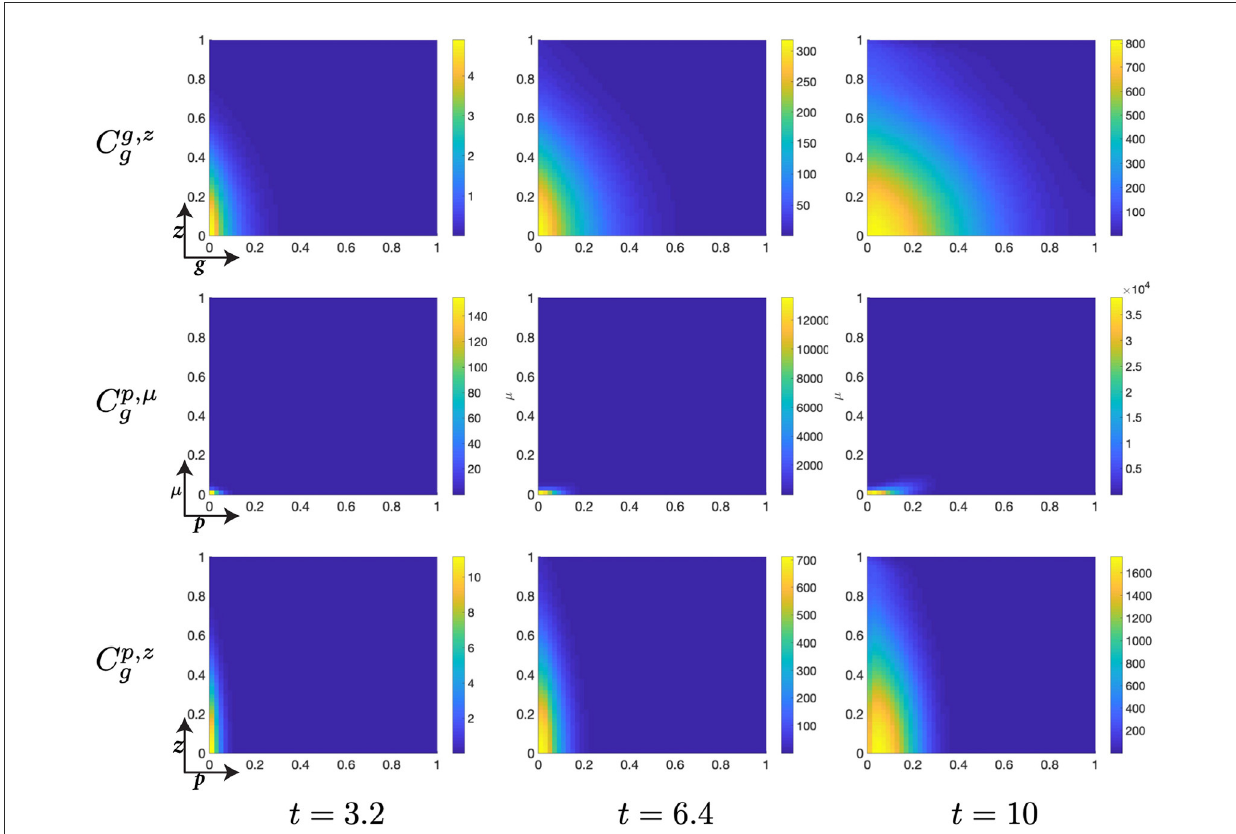
FIGURE12 Structured G-phase cell population given in: the G-cyclin-DNA-damage plane ( g , z ); the p53-mdm2 plane ( p , µ ); and the p53-DNA-damage plane, with a reduced mutational repair rate ( χ z